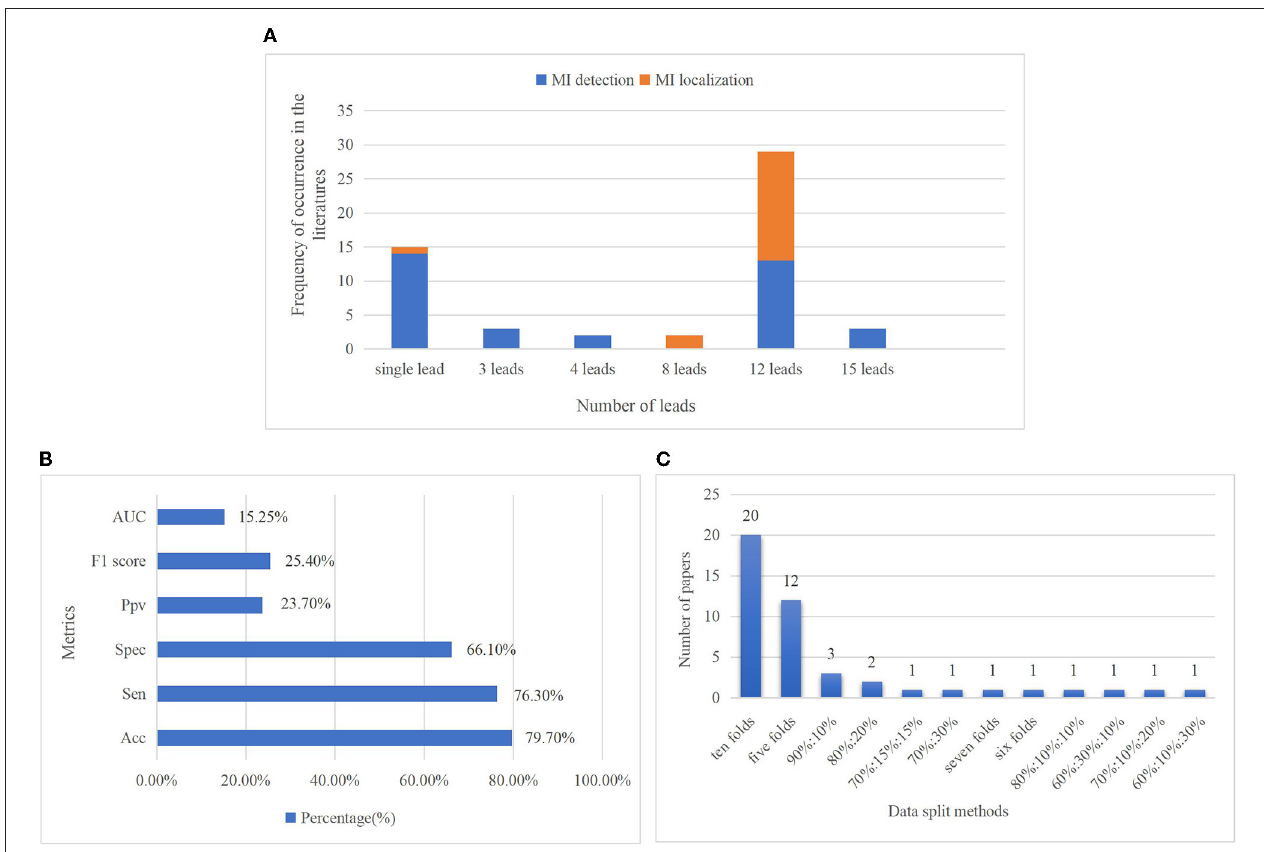
FIGURE 4 | The number of leads used in investigated articles (A) . The proportion of the usage of single lead especially the lead II ECG signals is the highest for MI detection, even higher than the standard 12-lead ECG signals. It is because this limb lead is coaxial to the cardiac conduction, the ECG signal in lead II has the largest forward waveform amplitude and the clearest waveform amplitude, so it can provide good ECG morphological information for MI detection ( 74). Furthermore, for the objective of MI localization, only 12-lead ECG data can provide comprehensive information and reflect different regions of the heart, so standard 12 lead ECG signals are employed in most research of MI localization. Percentage of metrics used in reviewed papers (B) . Accuracy, sensitivity, and specificity are the three major metrics. Accuracy, which is considered in 79.7% of the articles, is the most frequently used metric, followed by sensitivity and specificity, with rates of 76.3 and 66.1%, respectively. Less than 20% of authors have considered AUC. Distribution of data splitting methods in MI diagnosis (C) . They contain k-fold cross-validation (CV) such as ten- and five-folds, train-test separation such as 90:10 and 80:20%, and train-validation-test separation such as 70:15:15 and 60:10:30%. It shows tenfold CV is the most popular data splitting method, which has been considered in 20